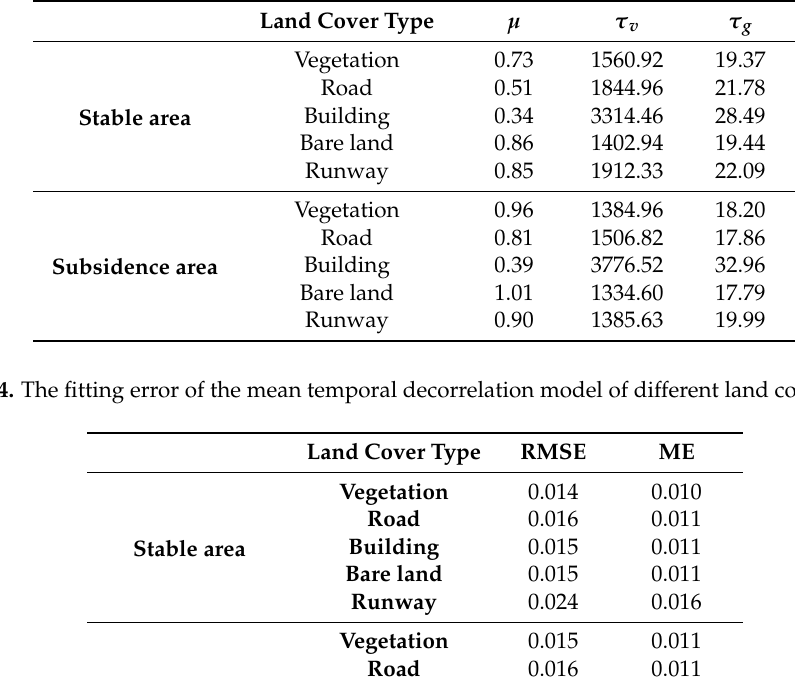
Table 3. The fitting parameters of the mean temporal decorrelation model of different land cover types.